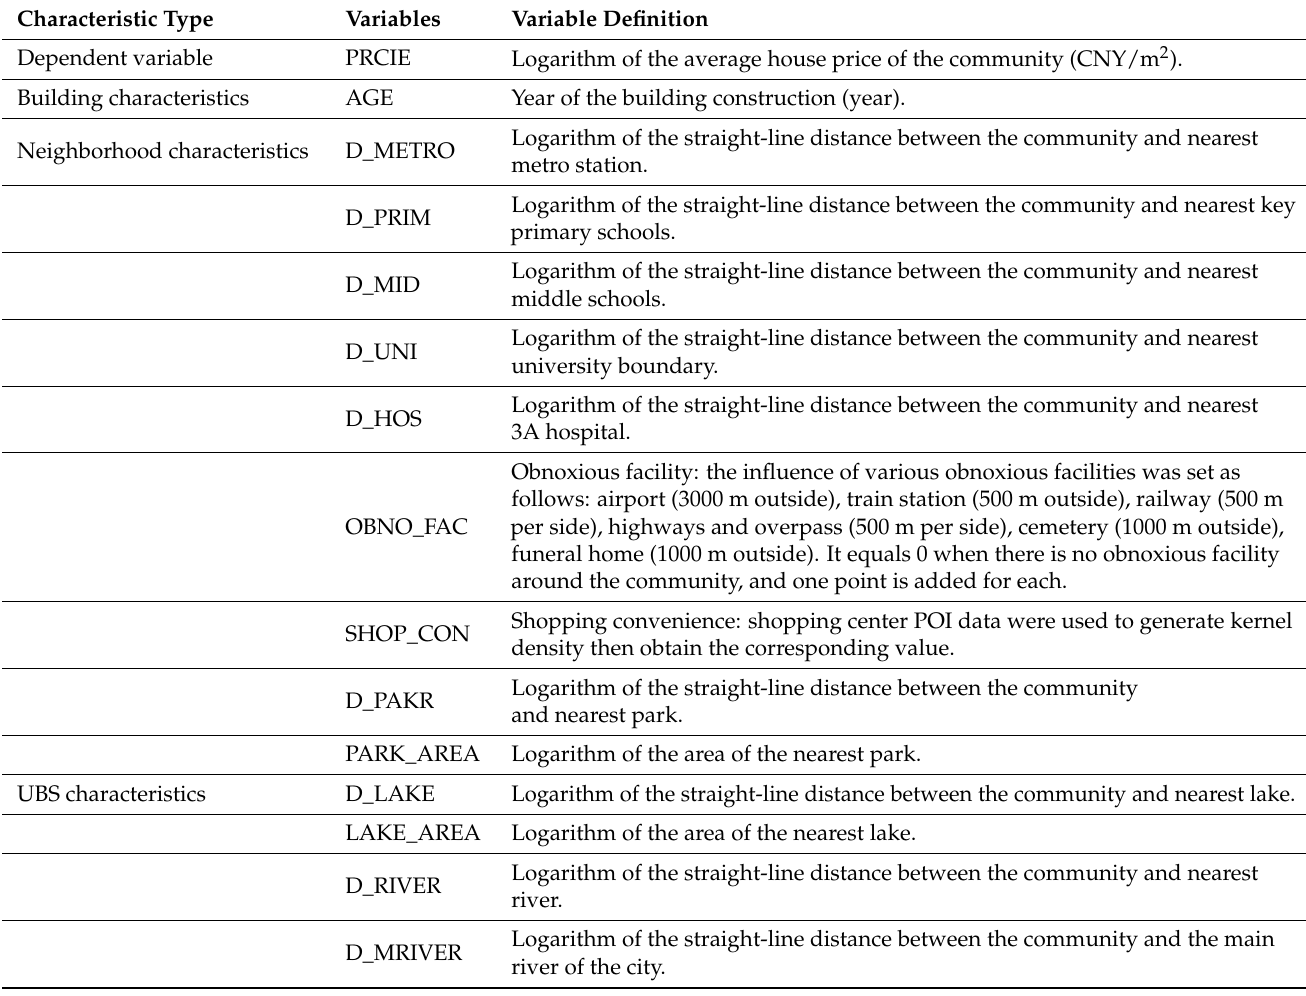
Table 2. Definition of main